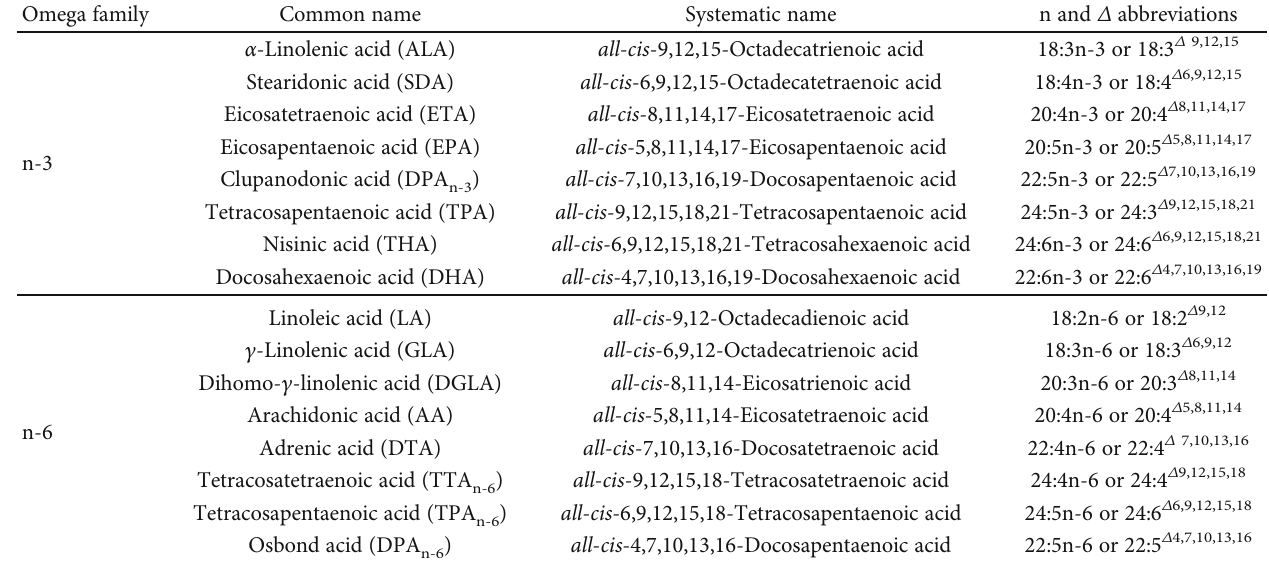
Table 1: List of the most common n-3 and n-6 PUFAs. Data elaborated from Ruiz-Lopez et al. [27] and Russo [33]. Omega